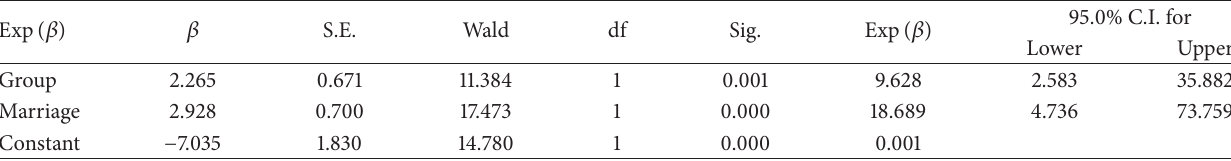
Table 2: Estimation of 𝛽 and Exp in PCOS